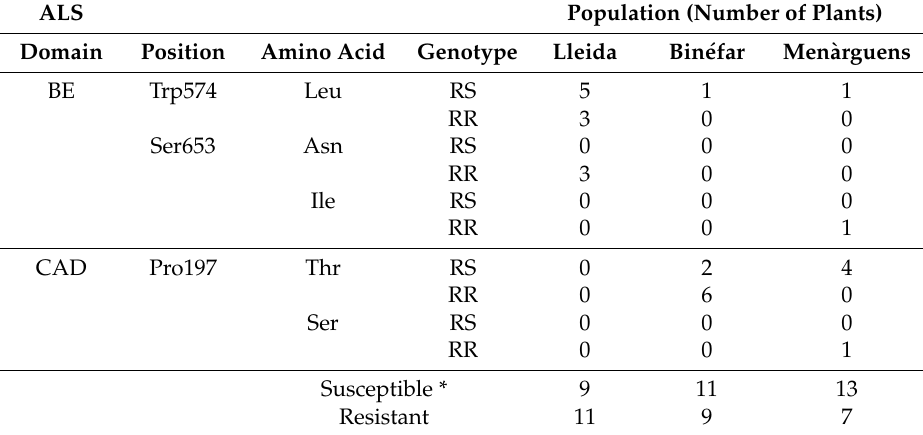
Table 5. Amino-acid sequence of three Spanish Amaranthus palmeri populations (20 plants for each one) for the ALS gene in BE and CAD domains. Only positions with amino acid change (Trp574, Ser653 and Pro197) and associated with resistance are represented. All sequences were compared with the wild type ALS gene (GenBank: AJ577316). Genotype column presents if plants were resistant (R) heterozygous (RS) or R homozygous (RR) for each position. ALS Population (Number of Plants) Domain Position Amino Acid Genotype Lleida Bin é far Men à rguens BE Trp574